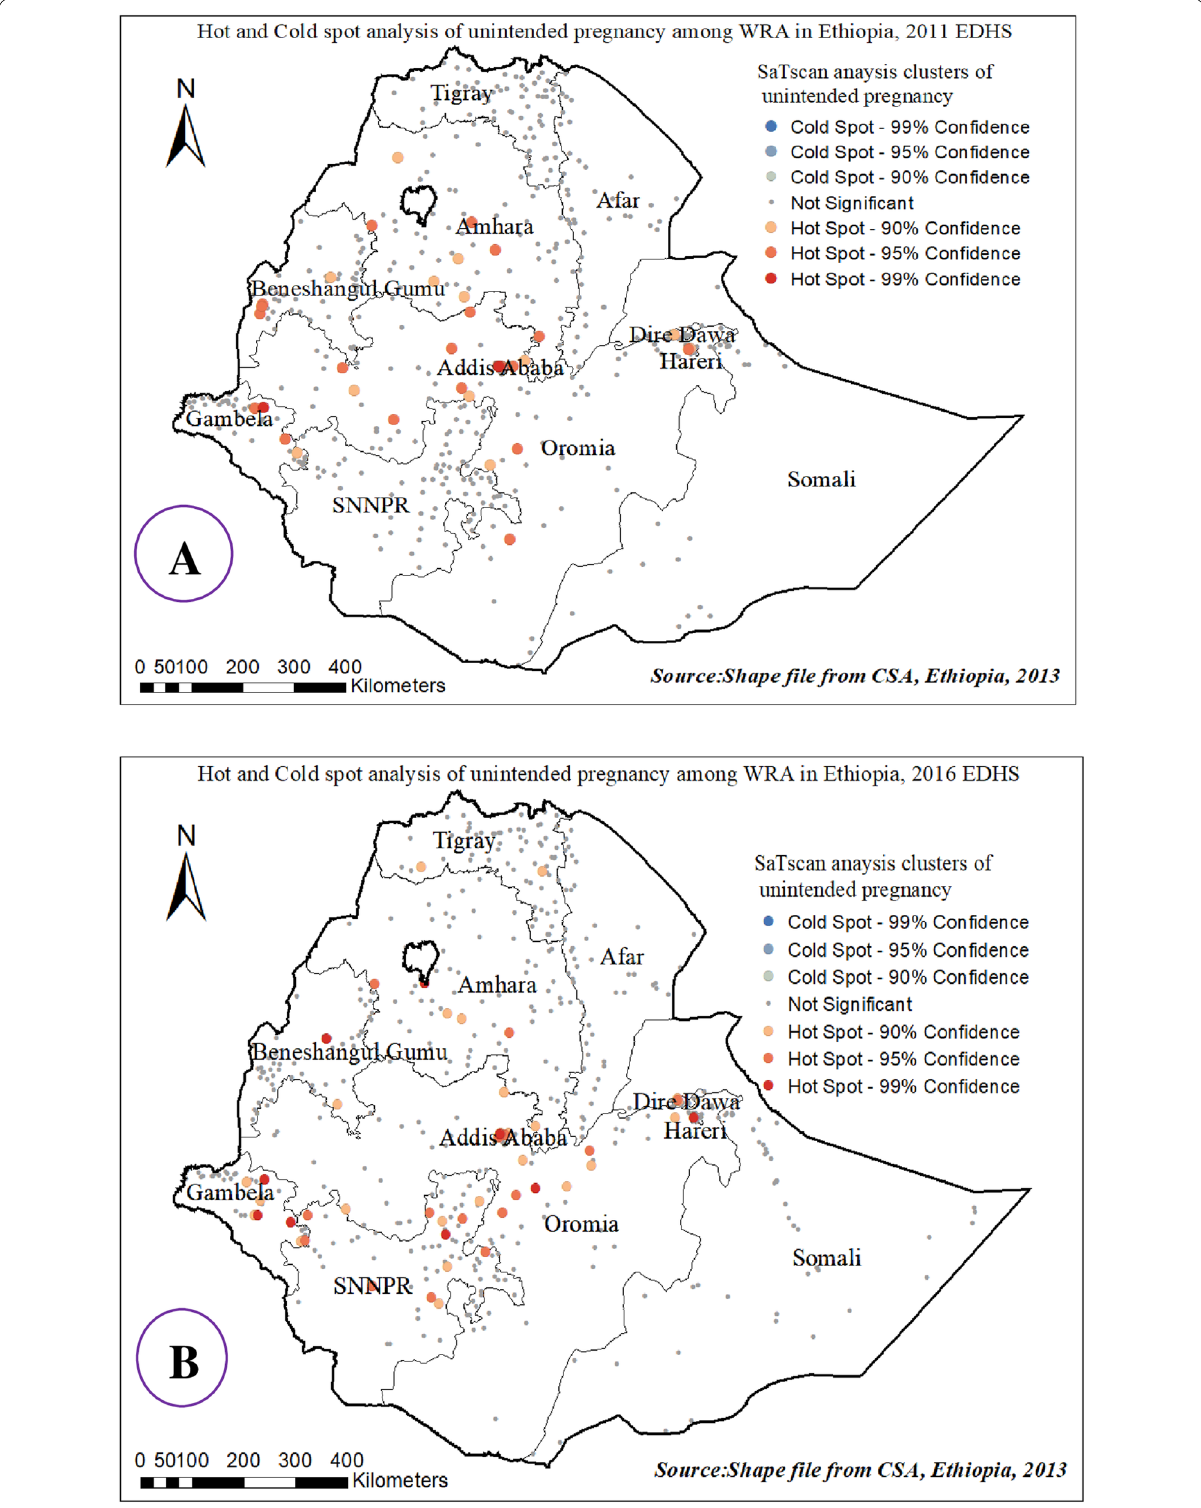
Fig. 5 Hot and cold spot areas of unintended pregnancy among reproductive-age women in Ethiopia, 2011 EDHS( A ) and 2016 EDHS ( B